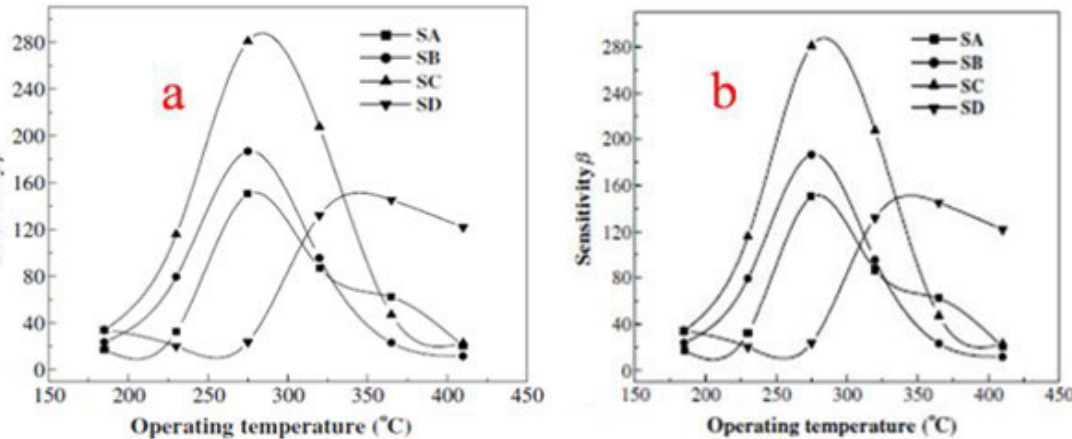
Figure 23. ( a ) The sensitivity of sensors with the effect of different operating temperatures at ( a ) 1000 ppm H 2 and ( b ) 1000 ppm C 2 H 5 OH. (Reprinted with permission from [45]. Copyright 2003, Elsevier).